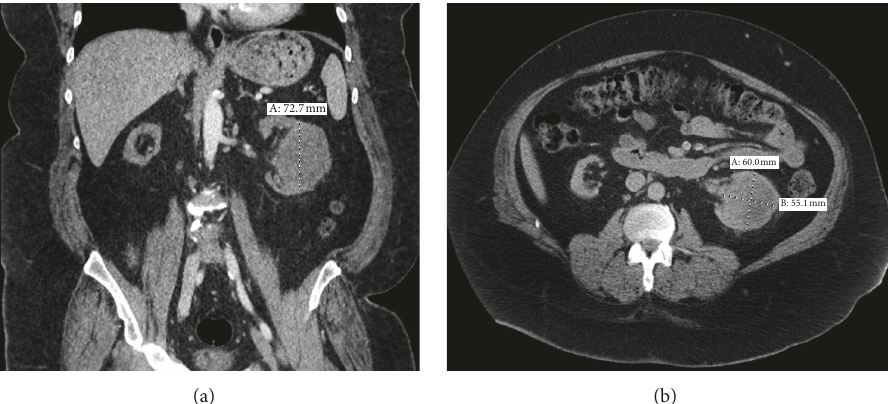
Figure 1: Coronal (a) and transverse (b) views of abdominal computed tomography demonstrate 7.27 × 6.00 × 5.50 cm heterogeneous mass in the left native kidney. Both kidneys show signs of